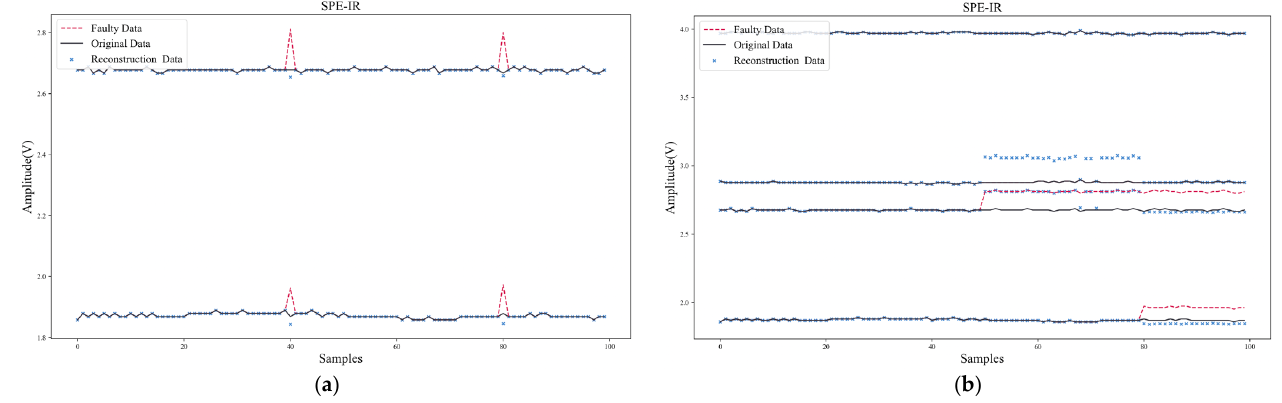
Figure 16. Multi-faults isolation and recovery of SPE-IR: ( a ) Multiple transient faults; ( b ) Multiple persistent faults.